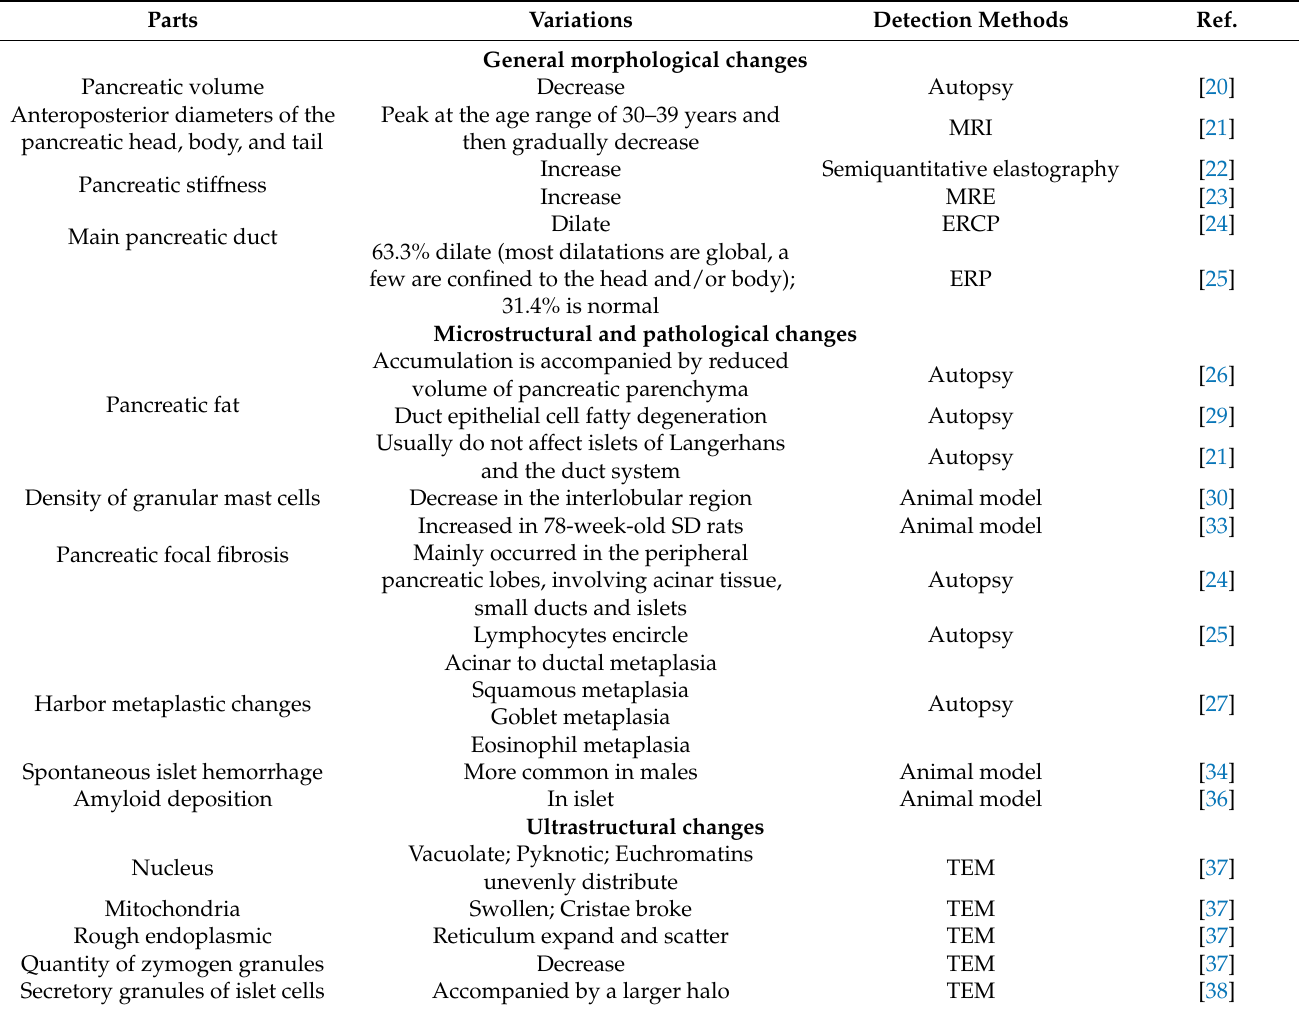
Table 1. Morphological and pathological changes in pancreatic